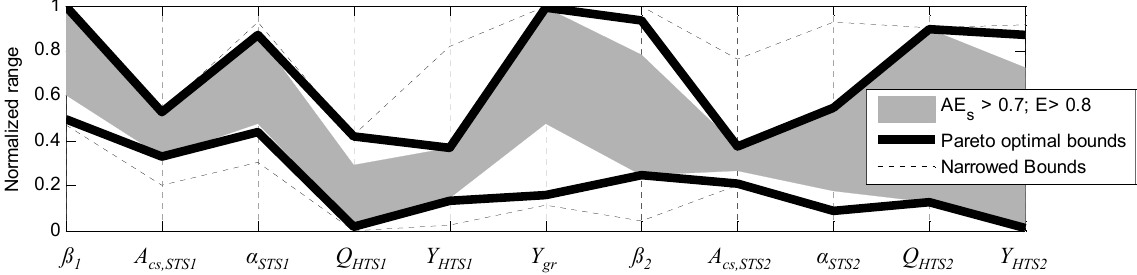
Fig. 10. The parameter sets which met the global and local performance criteria for multiple objective tests in Level 4, Test 9, are shown in grey within the bounds of all of the Pareto optimal parameter sets from Test 9 (black lines). The narrowed search space for the Level 3 and Level 4 calibrations, derived from the Level 1 and Level 2 results, is shown with the dashed line (shown as the grey area in Fig. 7). The a priori search space is the [0, 1] normalized bounds.